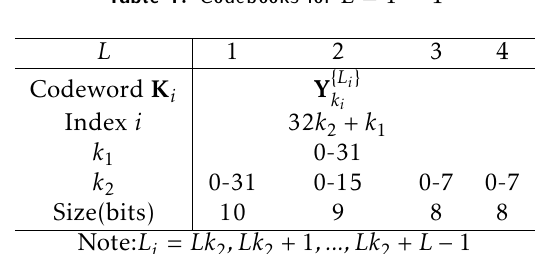
Table 1. Codebooks for L = 1 ∼